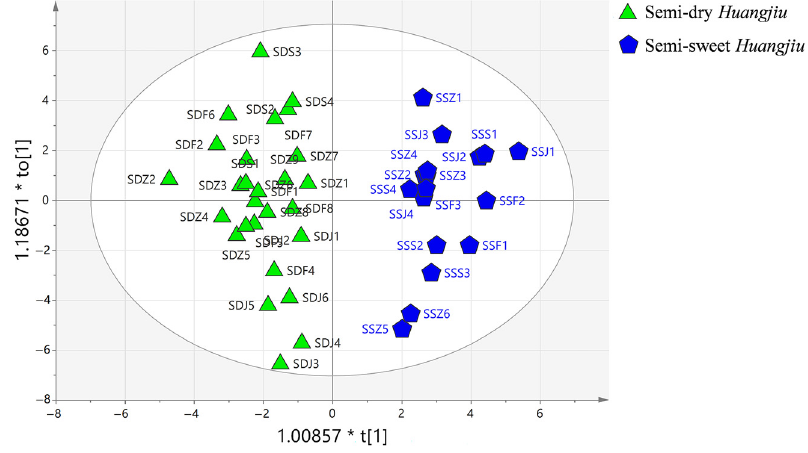
Figure 4. OPLS-DA of semidry Huangjiu and semisweet Huangjiu . Table 4. List of volatile carbonyl compounds significantly altered in semidry Huangjiu compared to semisweet Huangjiu (only signals p < 0.05 and VIP > 1 are presented). Figure 5. OPLS-DA of rice Huangjiu and nonrice Huangjiu. Table 5. List of volati le carbonyl compounds significantly altered in rice Huangjiu compared to non- rice Huangjiu (only signals p < 0.05 and VIP > 1 are presented).